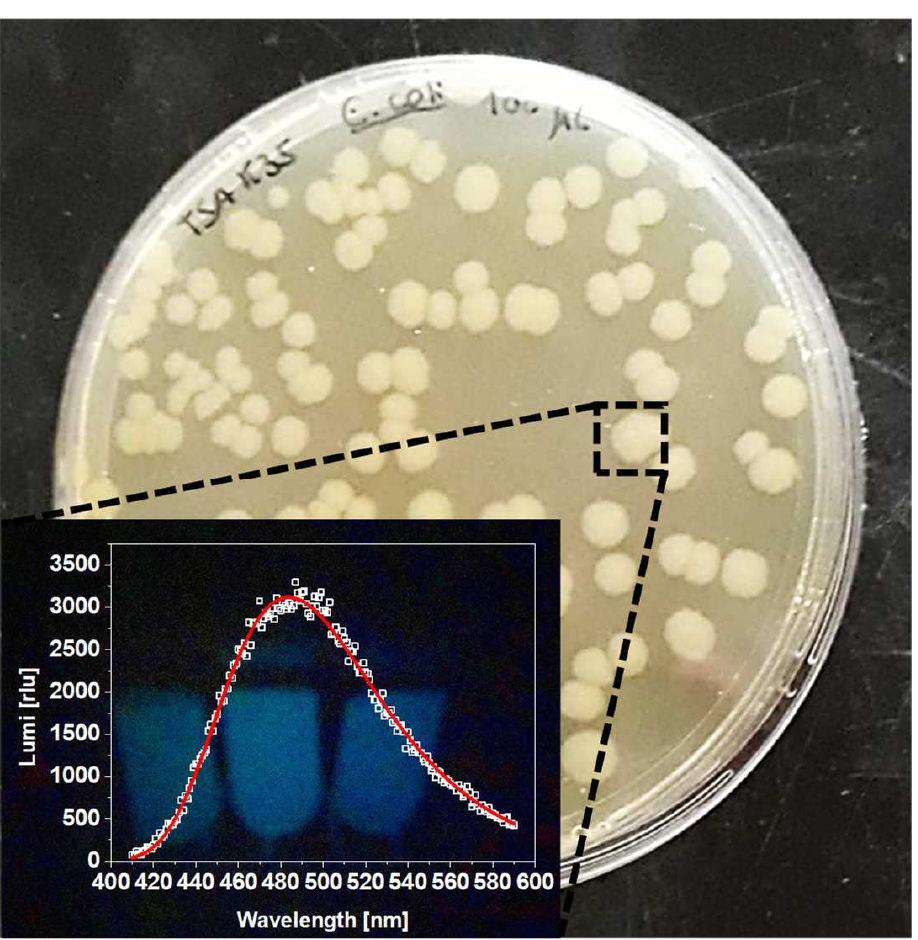
Figure 1. Bacterial transformants after electroporation; inset: E. coli LUX typic luminescence spec- trum.